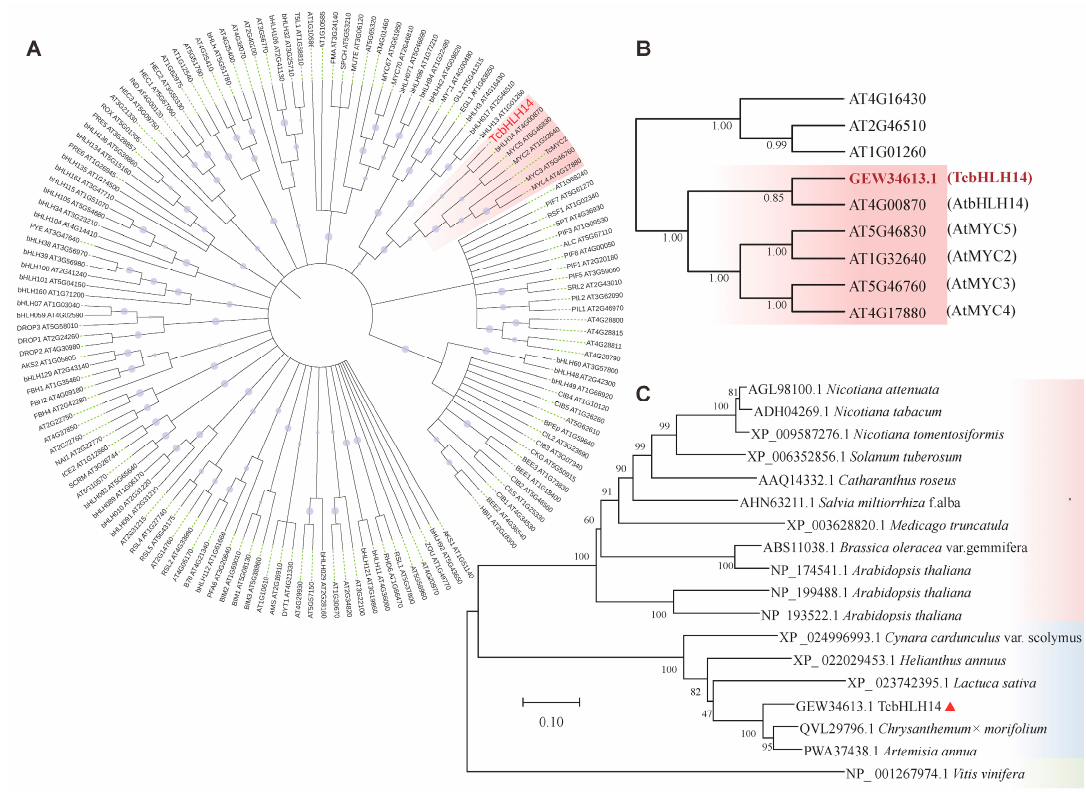
Figure 1. Phylogenetic analysis of TcbHLH14 and other bHLH proteins. ( A ) Phylogenetic analysis of bHLH transcription factors of A. thaliana and T. cinerariifolium . ( B ) The branch including TcbHLH14 and AtbHLH14 is marked with a pink background; TcbHLH14 is displayed in red font. ( C ) Phylogenetic analysis of TcbHLH14 and bHLH proteins of other plants; TcbHLH14 is marked with the red triangle; the green box indicates Vitaceae, the blue box represents Asteraceae, and the pink box includes Brassicaceae Burnett, Fabaceae, Apocynaceae, and Solanaceae. The tree was constructed by the neighbor-joining method with 1000 bootstrap replicates.